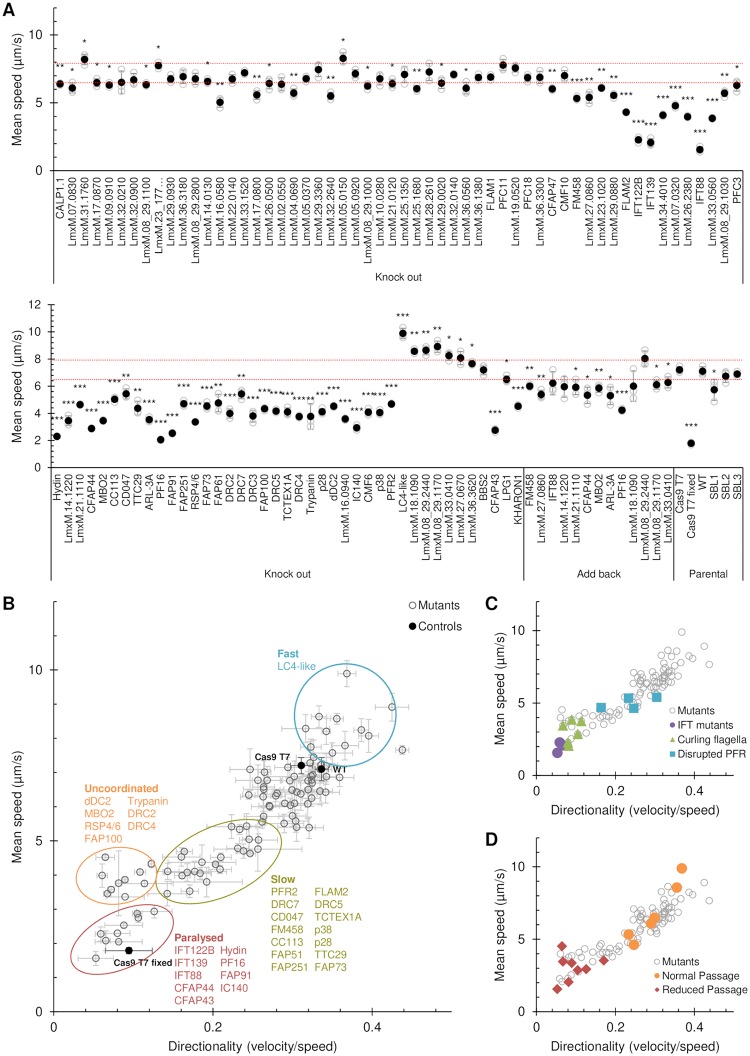
Identification of motility phenotypes.All deletion cell lines generated in this study and the ΔPF16 mutant [23] were analysed for defects in swimming speed or directionality (the ratio of velocity to speed). (A) Mean swimming speeds. Speeds were measured three times and the mean of all three replicates (●) and the individual replicates (○) are shown. Error bars represent the standard deviation. Red dotted lines indicate two standard deviations above and below the parental cell line (Cas9 T7) mean swimming speed. Cas9 T7 cells killed with 1% formaldehyde (Cas9 T7 fixed) were used as a completely immotile control. *** p<0.0005, ** p<0.005, * p<0.05 (Student’s t-test compared to the parental cell line). SBL1, SBL2 and SBL3 are barcoded parental cell lines used in pooled assays. For a sub-set of mutants, an addback copy of the deleted gene was introduced and swimming speeds restored toward the wild-type. (B) The swimming speeds of all knockout mutants (○), as in (A), plotted against mean directionality. Error bars represent the standard deviation of the three replicates. Four main mutant phenotype clusters are apparent: Paralysed (including mutants lacking a long flagellum), uncoordinated (which move slowly, but with greatly reduced directionality), slow (which move slowly, but with reduced directionality and speed) and fast (which move faster, with a tendency for higher directionality). (C) Speed and directionality of all knockout mutants in (B) with deletion of IFT components, mutants with a tendency for curling of the flagellum (S9 Fig) or disrupted PFR structure (Fig 5) highlighted. (D) Speed and directionality of knockout mutants in (B) with those passaged though sand flies (Fig 6) highlighted.